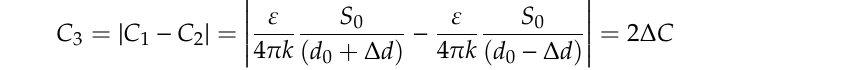
Figure 2. State diagram of the combs before and after rotation. ( a ) clockwise; ( b ) counter-clockwise. C between 1# fixed plate and 2# fixed plate can be obtained: Based on plate capacitors’ definition, 3